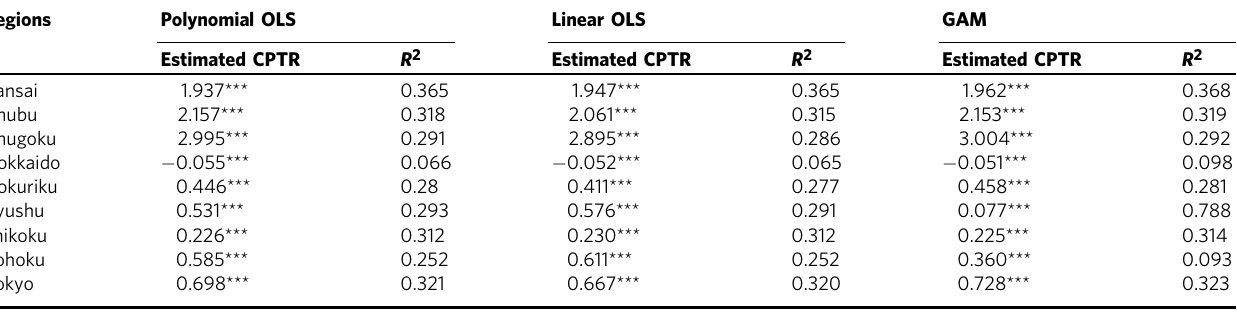
Table 6 Comparative analysis for the key indicator (carbon pass-through rate) among different models. Regions